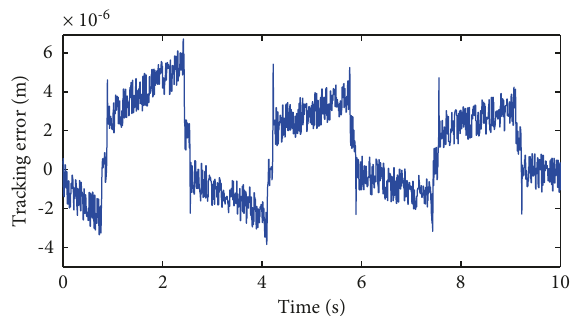
Figure 10: Sinusoidal input tracking error curve of adaptive friction compensation